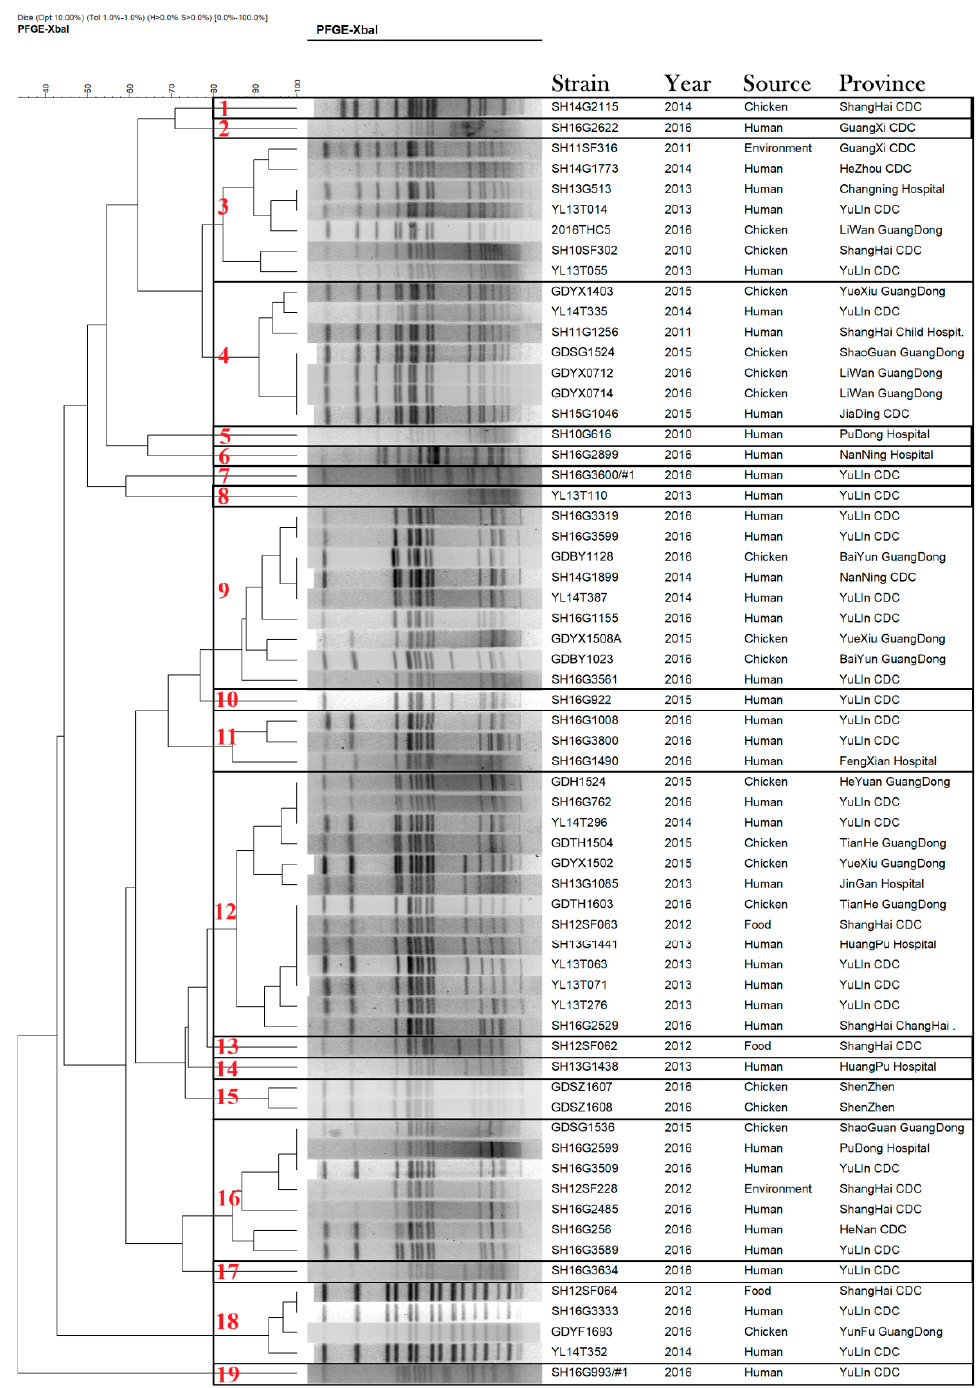
Figure 3. Dendrogram of 63 pulsed-field gel-electrophoresis-based profiles of Salmonella enterica serovar Kentucky ST198 strains isolated from human, environmental, and chicken samples in China, 2010–2016.